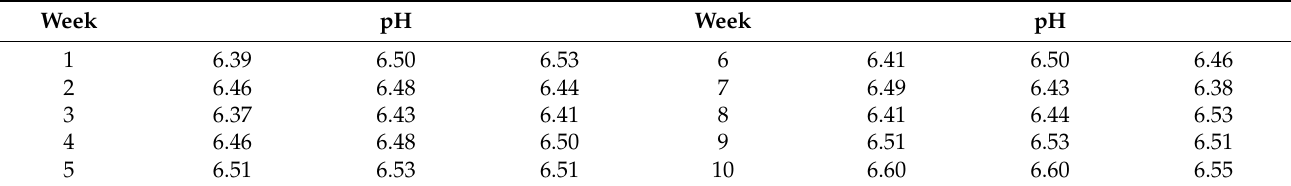
Table 7. Corrected pH values obtained for electrode A.